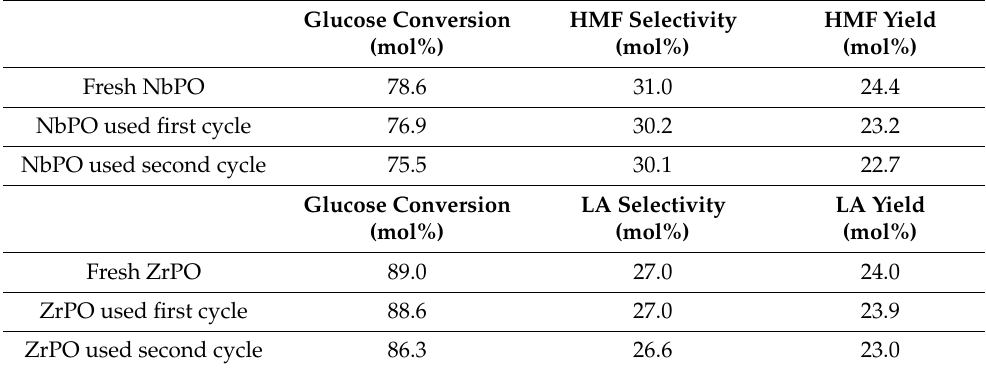
Table 6. Glucose conversion in the presence of NbPO (T = 160 °C) and ZrPO (T = 180 °C) under the same reaction conditions (6 h, glucose/catalyst weight ratio = 1.2, glucose loading = 5 wt%) and two subsequent recycles of the solid catalysts.